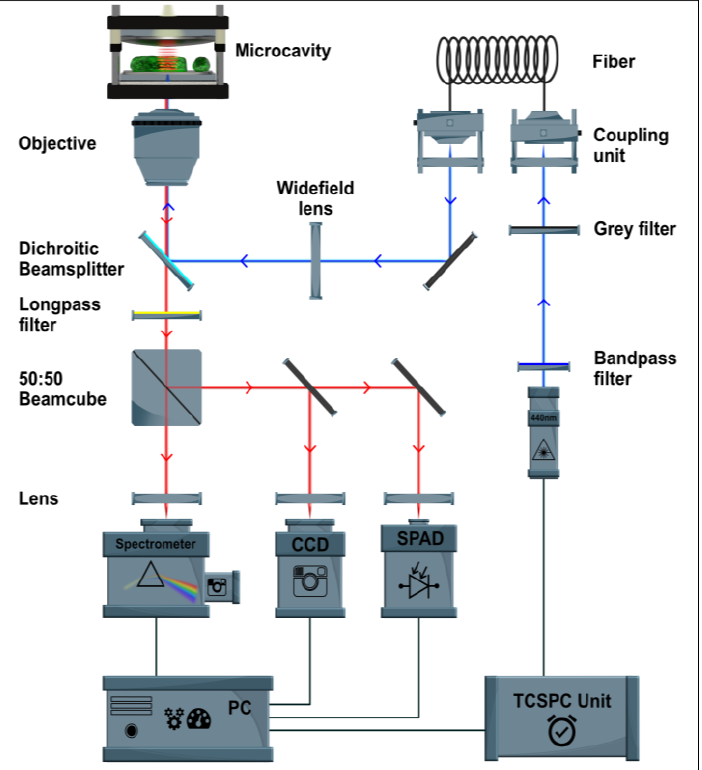
Figure 4. Home-built semi confocal microscope.